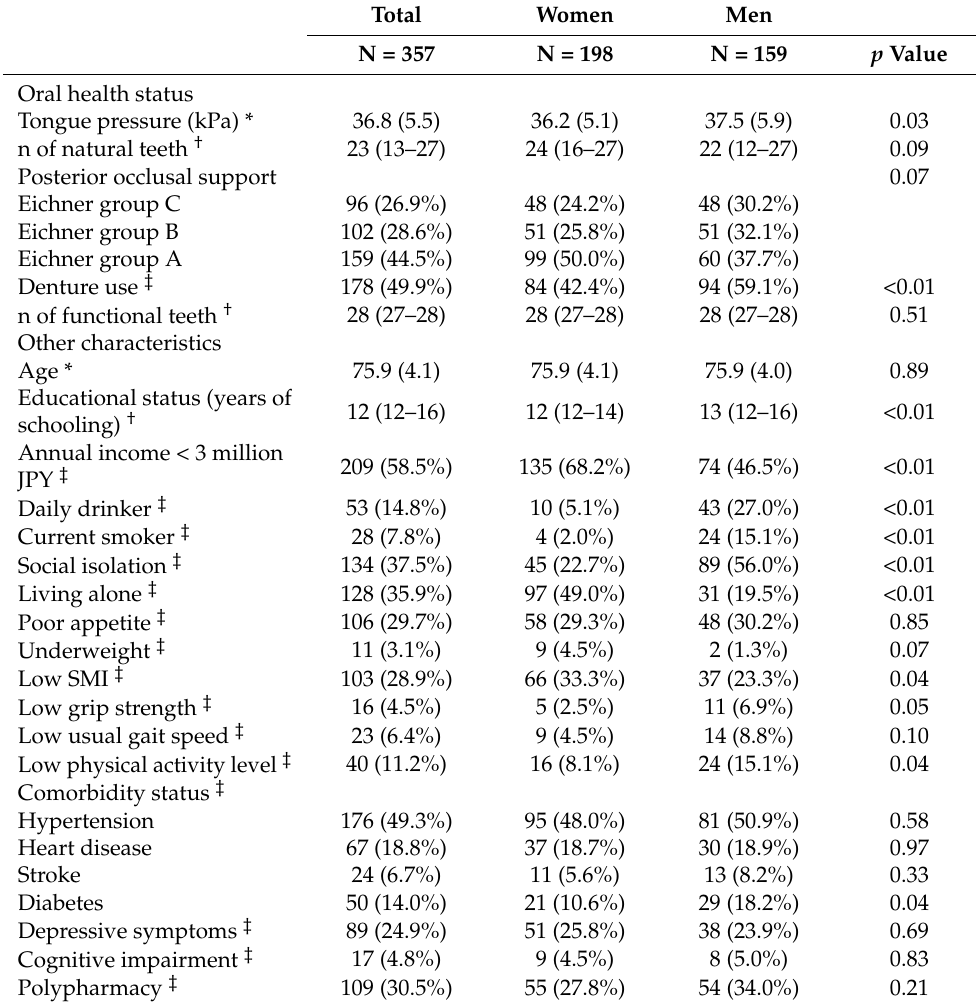
Table 1. Baseline characteristics of the study population according to